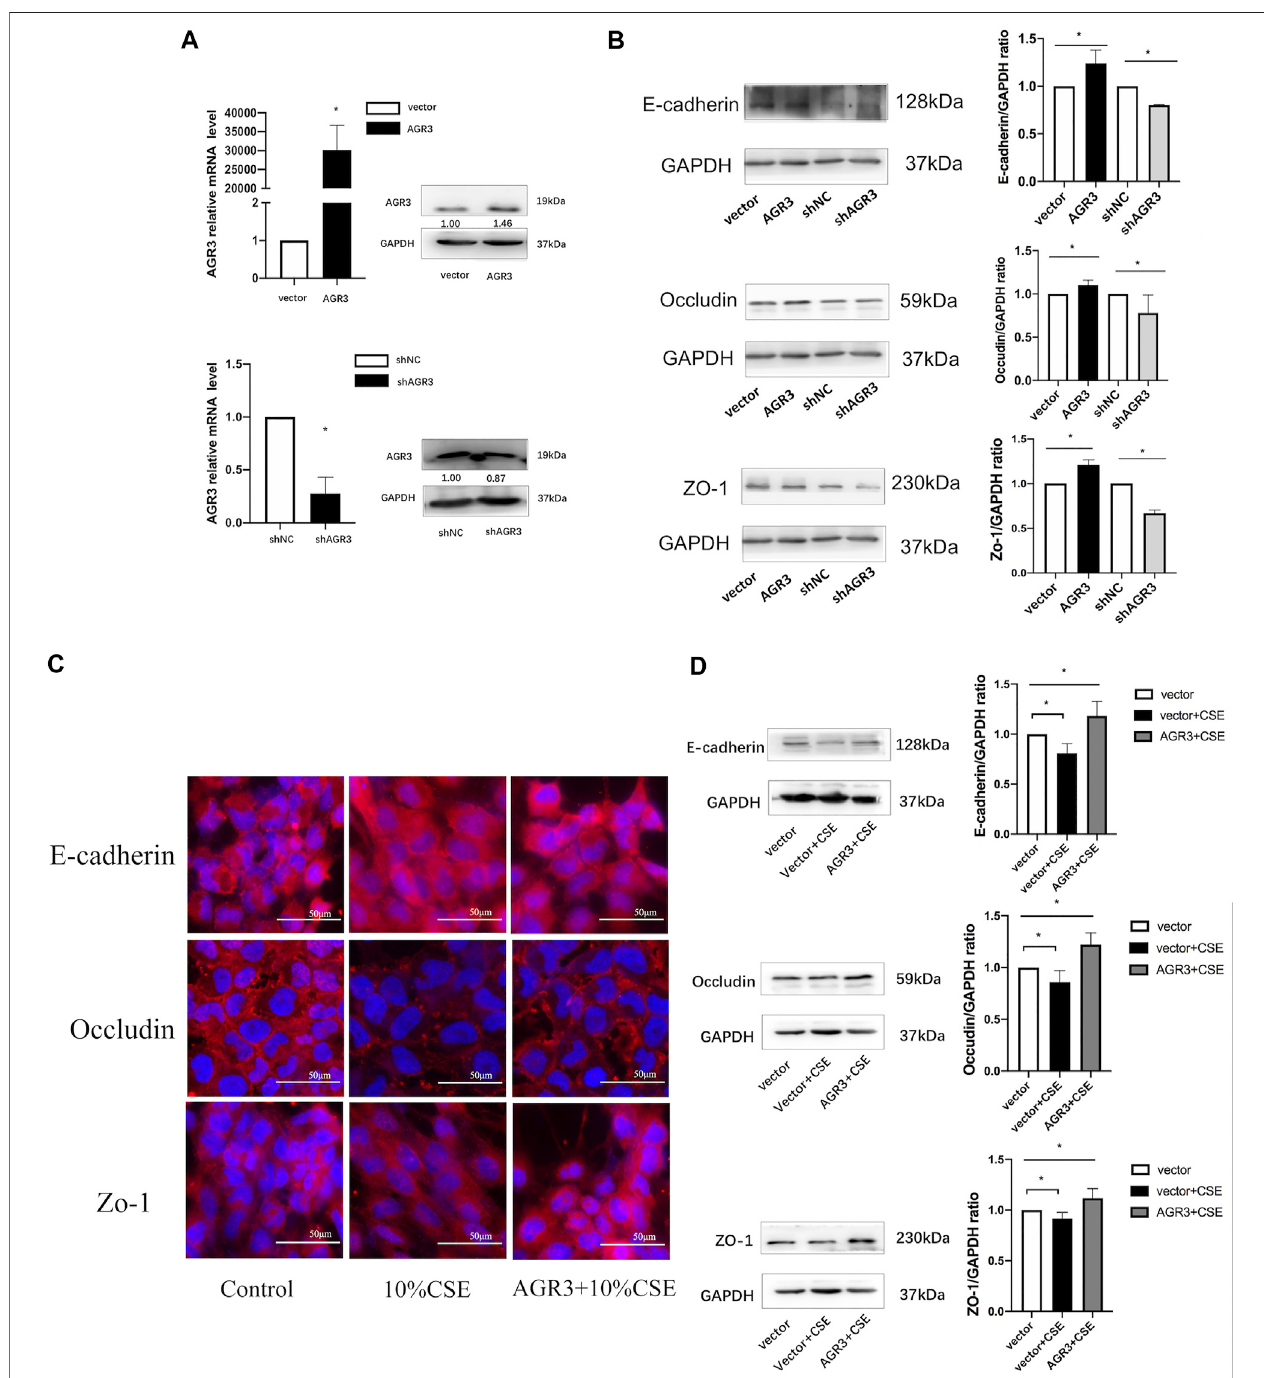
FIGURE4| EffectsofAGR3onE-cadherin,Occludin,andZO-1expressioninBEAS-2Bcells. (A) AGR3overexpressedandsilenced inBEAS-2Bcells. (B) Protein expression ofoccludin,ZO-1,and E-cadherininAGR3overexpressed and silencedBEAS-2B cells. (C) Immuno fl uorescencestainingforE-cadherin, Occludin,and ZO- 1 in Control cells or AGR3 overexpressed cells with 10% CSE exposed for 24 h. (D) Western blot analysis for E-cadherin, Occludin, and ZO-1 in Control cells or AGR3 overexpressedcellswith10%CSEexposedfor24 h.Bandintensitywasquantitatedusingdensitometry.Allresultsarerepresentativeofatleastthreeindependent experiments. Data are shown as the mean ± SD. * p < 0.05 by one-way ANOVA.